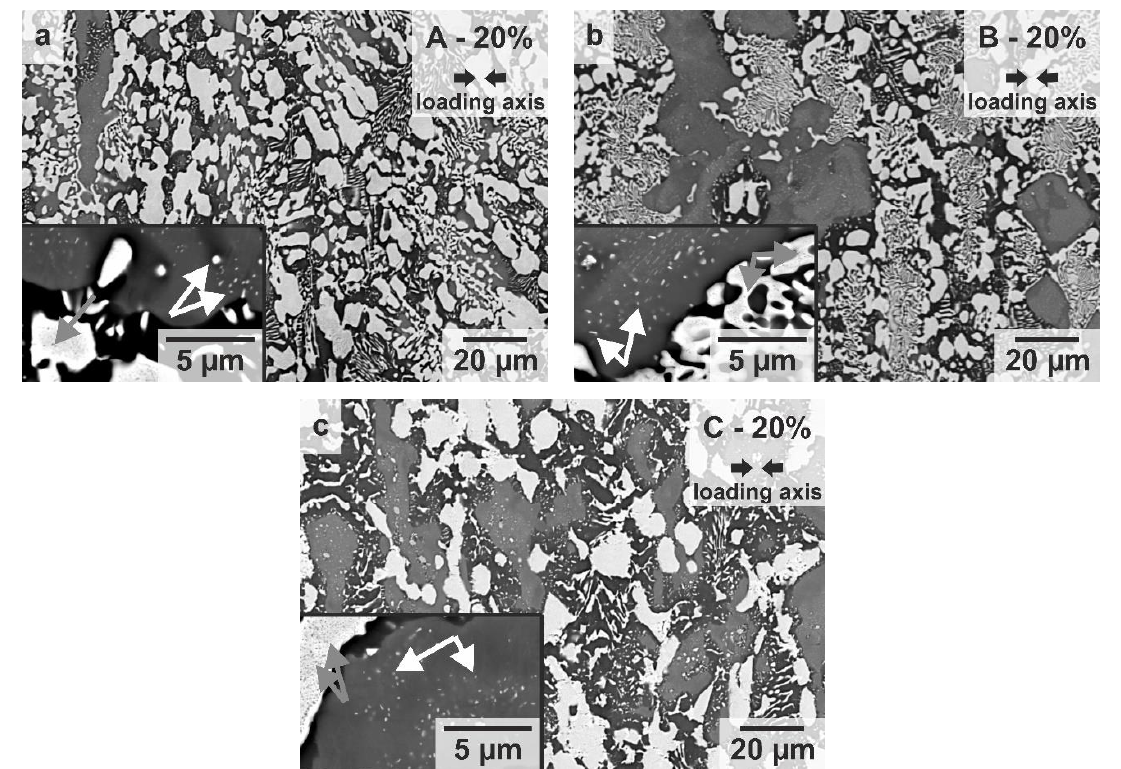
Figure 8. BSE micrographs of the microstructures of the alloys A to C ( a – c ) after creep deformation at 1200 °C and 200 MPa up to 20% true compressive strain. The insets provide higher magnification images of regions with primarily solidified (Mo,Ti) 5 Si 3 and the surrounding microstructural constituents. Precipitation of Mo-rich particles is observed within the (Mo,Ti) 5 Si 3 regions (highlighted by white arrows), as well as of Mo-lean particles within Mo SS regions (highlighted by grey arrows).